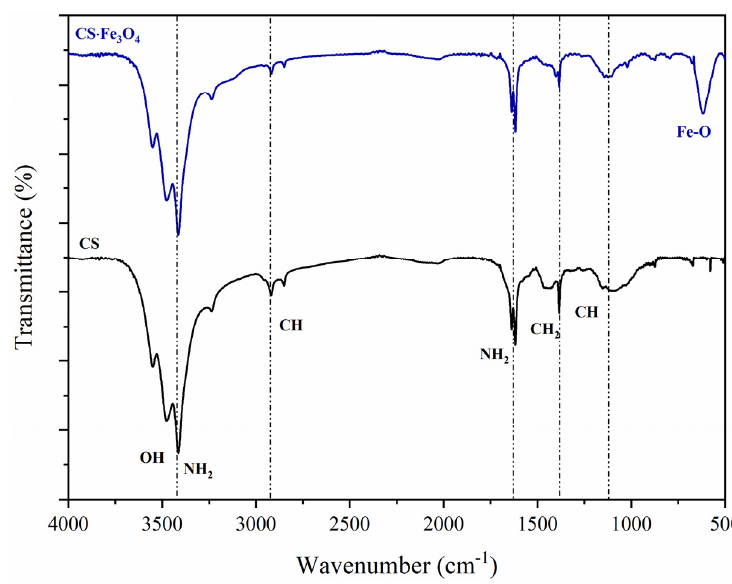
Figure 2. FTIR spectra of chitosan and magnetic chitosan.